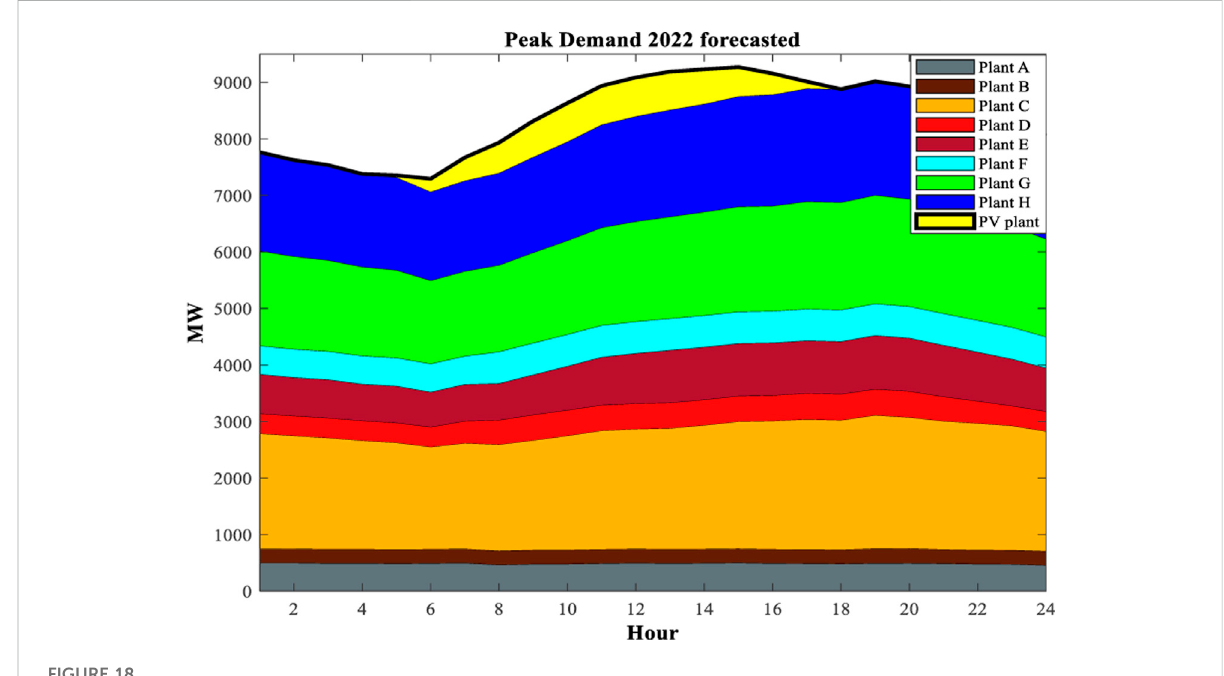
FIGURE 18 The forecasted peak demand in 2022.